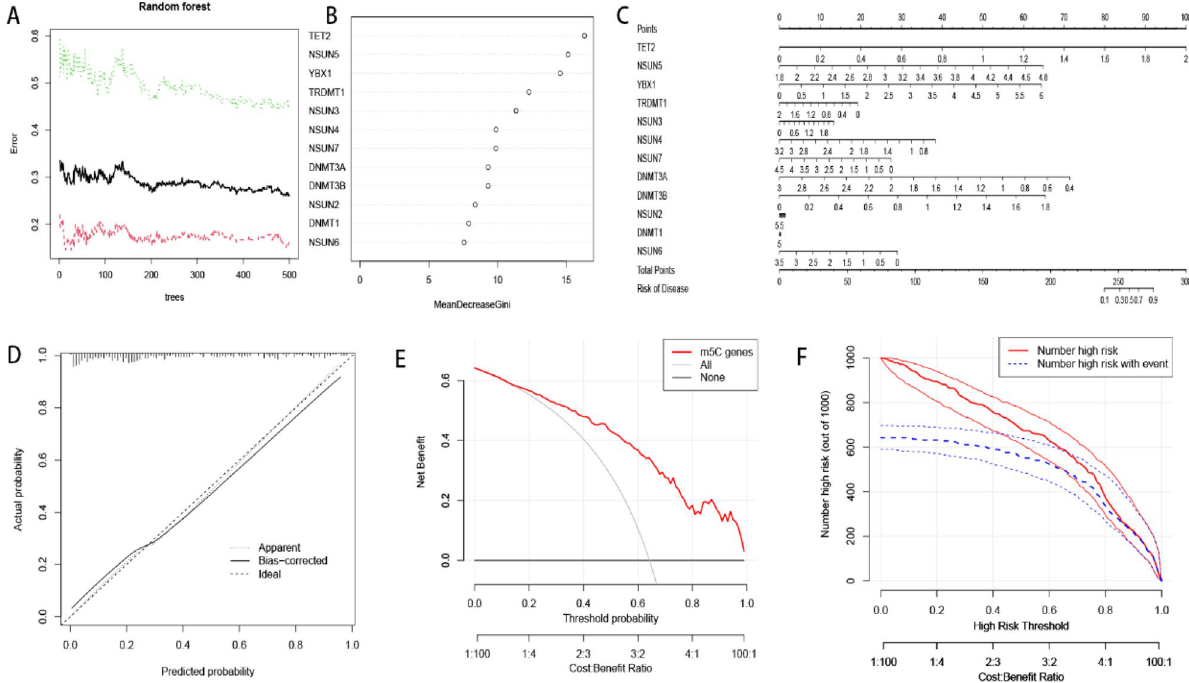
Figure 4. The RF and nomogram model construction. ( A ) The red line represented the error levels of treat groups, the green line represented control groups and the black line represented overall samples. ( B ) The importance of the m5C regulators were calculated based on the RF model. ( C ) The construction of nomogram model and gene score was used to predict prevalence. ( D ) The accuracy of nomogram model was assessed by calibration curve. ( E ) The decision curve might be benefit to the disease. ( F ) Clinical impact curve was applied for assessing clinical impact of the